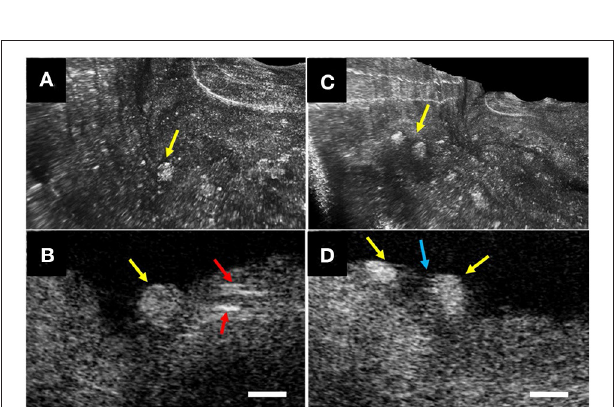
FIGURE 7 | Intravascular µ OCT for inflammatory cells in human cadaver coronaries ex vivo. (A) Individual macrophages (yellow arrows) residing on the surface of a fibroatheromatous plaque that (B) appeared to be transmigrating through the endothelium toward a deposit of intimal cholesterol crystals (red arrows). (C) 3D- µ OCT image showing a pair of macrophages tethered to the surface, (D) polarized toward one another with extended pseudopodia (blue arrow). Scale bars, 50 µ m. Figure and capture reprinted with permission from Yin et al.